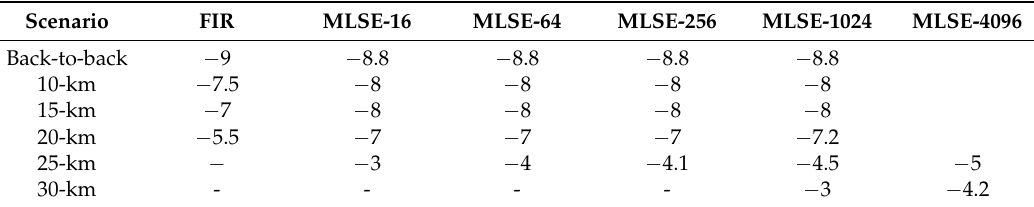
Table 1. Sensitivity requirements of the scheme of Figure 1a at 7% hard decision forward error correction code (HD-FEC)